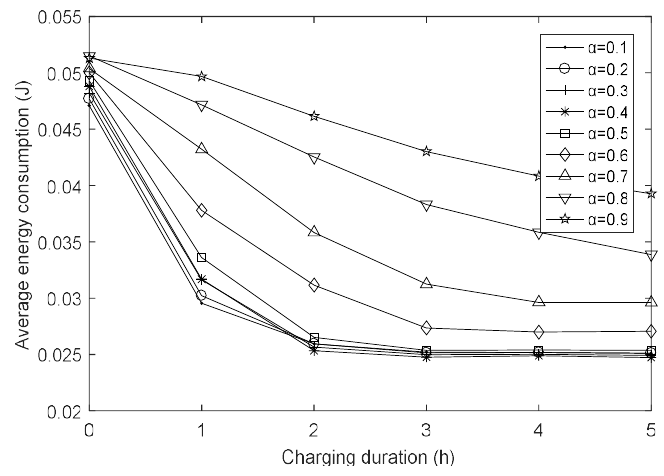
Figure 10. Average energy consumption with varying charging duration.